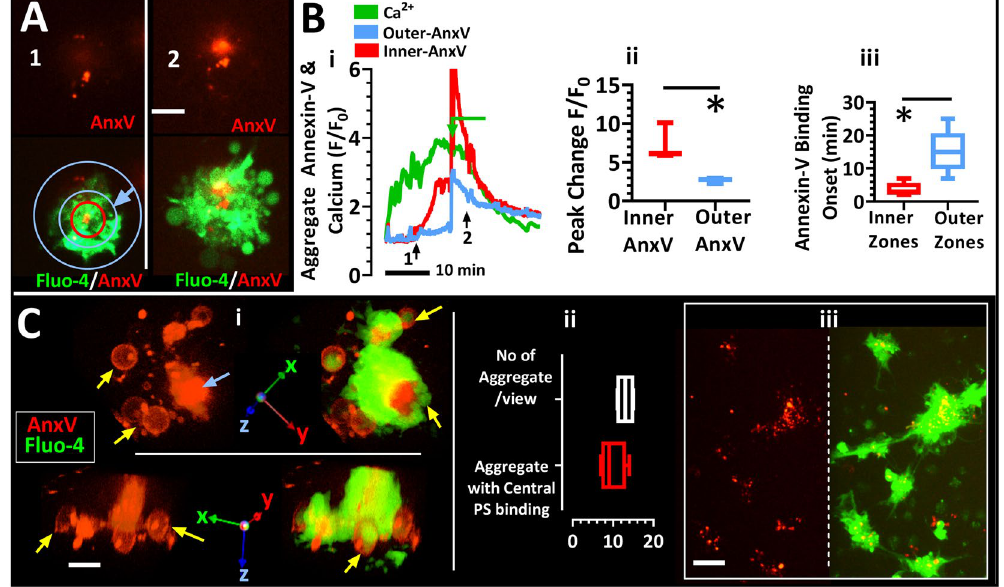
Figure 2. Initiation of Ballooning and Phosphatidylserine Exposure at Central Regions of Aggregated Human Platelets on Collagen-Coated Surfaces. Images are of Alexa568-Annexin-V (AnxV, red) or merged with Fluo-4 (green). ( A ) An aggregate of human platelets in re-calcified platelet rich plasma showing the presence of centralised phosphatidylserine (PS) exposure. Time points of images in A correspond to times indicated by black arrows in Fig B-i. The outer region of the aggregate was defined as ≤ 6 µ m (inwards, blue arrow, A) from the outermost membrane of the aggregate after ballooning and inner region as the circular area covered by 3 µ m radius drawn from the point of initial annexin-V accumulation within the aggregate (A). ( B-i ) real-time binding of annexin-V in the outer (between blue circles) and inner (within red circle) zones of the aggregate in (A). Peak change and onset of annexin-V binding in these regions are plotted in B-ii and B-iii, respectively. ( C ) C-i, 3D images of a representative platelet aggregate with the blue arrow pointing to the region of centralised ballooning and PS exposure and the yellow arrows pointing to ballooned platelets. The statistics of this observation are shown in C-ii. C-iii shows a field of view of several aggregates with central PS binding prior to ballooning of platelets in the aggregate periphery. Figure A is related to Movie_S1. Charts B-ii, B-iii and C-ii show interleaved box plots with whiskers showing minimum to maximum values, median, and interquartile range. Data analysis was by Wilcoxon Signed Rank Test. * P < 0.05 was considered significant. Scale bar represents 5 µ m (A and C). Data were from 10–15 aggregates (of 7–40 platelets) per view; and 35 ± 5 aggregates were analysed for each of 5 donor blood